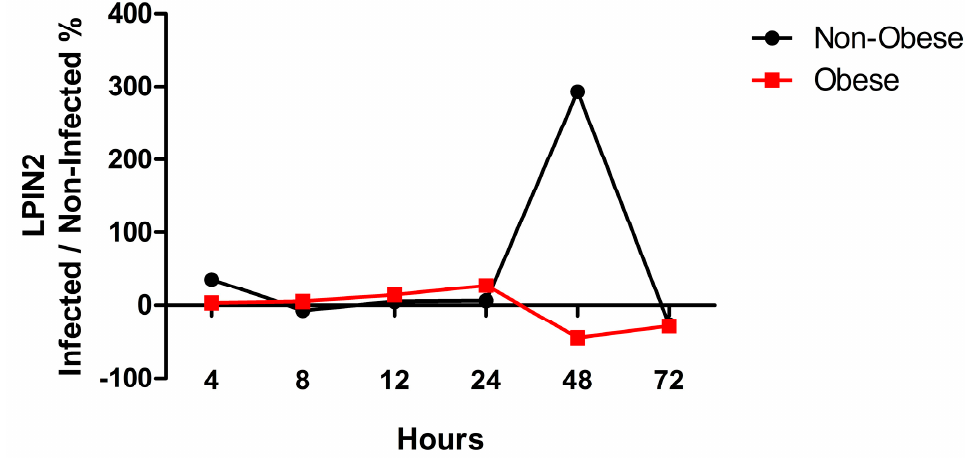
Figure 5. Differential expression of LPIN2 over infection time between cells from non-obese and obese subjects. The percentage of change of LPIN2 expression in infected compared to non-infected NHBE cells.